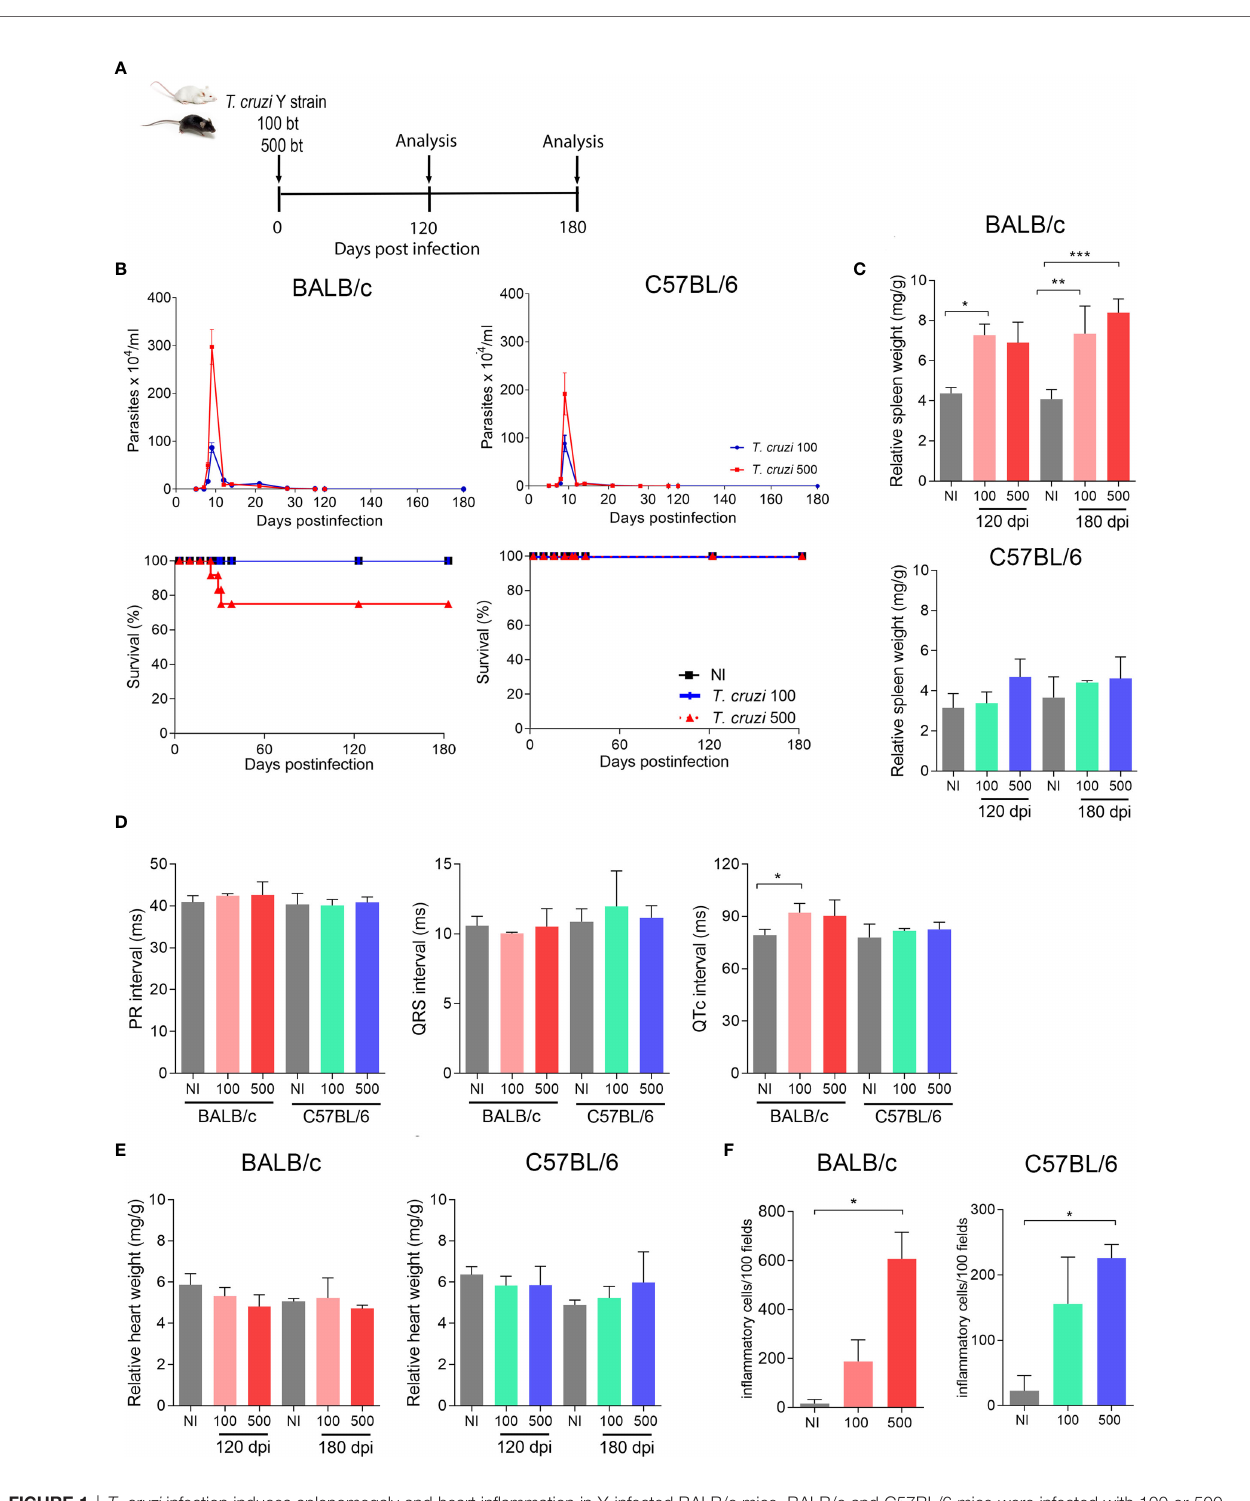
FIGURE 1 | T. cruzi infection induces splenomegaly and heart in fl ammation in Y-infected BALB/c mice. BALB/c and C57BL/6 mice were infected with 100 or 500 bloodstream trypomastigotes (Y strain). (A) Experimental design. (B) Parasitemia and survival curves. (C) Relative spleen weight. (D) ECG records showing PR and QTc intervals and the QRS complex (ms). (E) Relative heart weight. (F) In fl ammatory cells in heart tissue at 120 dpi. Data are represented as means ± SEM. Data represent three to four mice per group. Signi fi cant differences between infected and uninfected groups. *p < 0.05; **p < 0.01 ***p < 0.001 (Student ’ s t-test; Kruskal – Wallis Dunn ’ s posttest; one-way ANOVA, Tukey posttest)